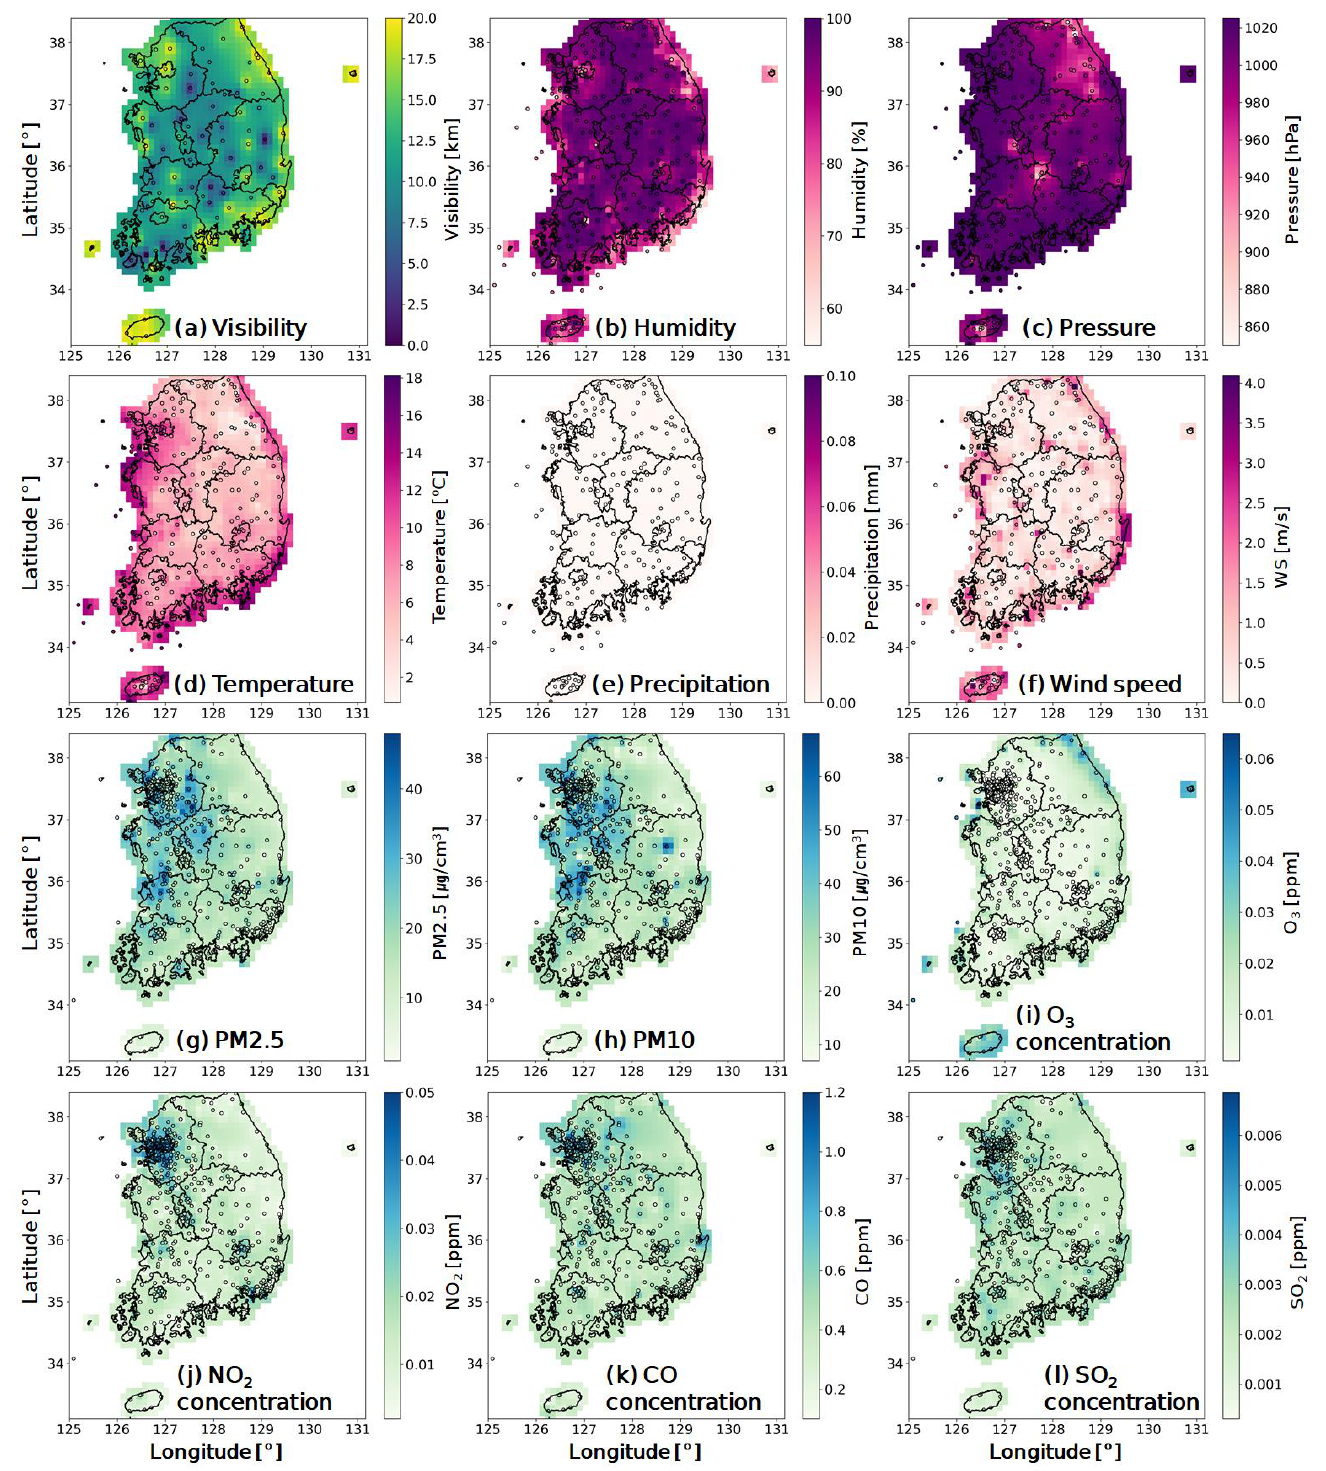
Figure 3. IDW interpolation results and ground-based observations of ( a ) visibility, ( b ) humidity, ( c ) pressure, ( d ) temperature, ( e ) precipitation, ( f ) wind speed, ( g ) PM2.5, ( h ) PM10, ( i ) O 3 , ( j ) NO 2 , ( k ) CO, and ( l ) SO 2 concentrations. The circle symbols indicate observed values.